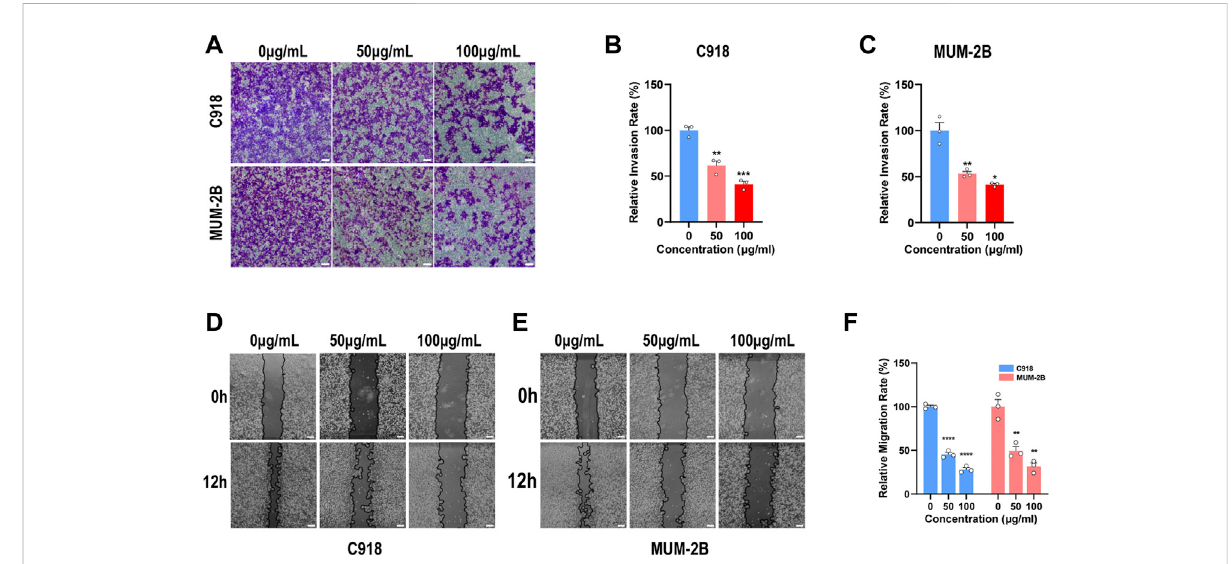
FIGURE 4 NMQDs-Ti 3 C 2 Tx inhibits UM cell invasion and migration (A,B and C) The transwell assay of the UM cells cultured with different concentrations of